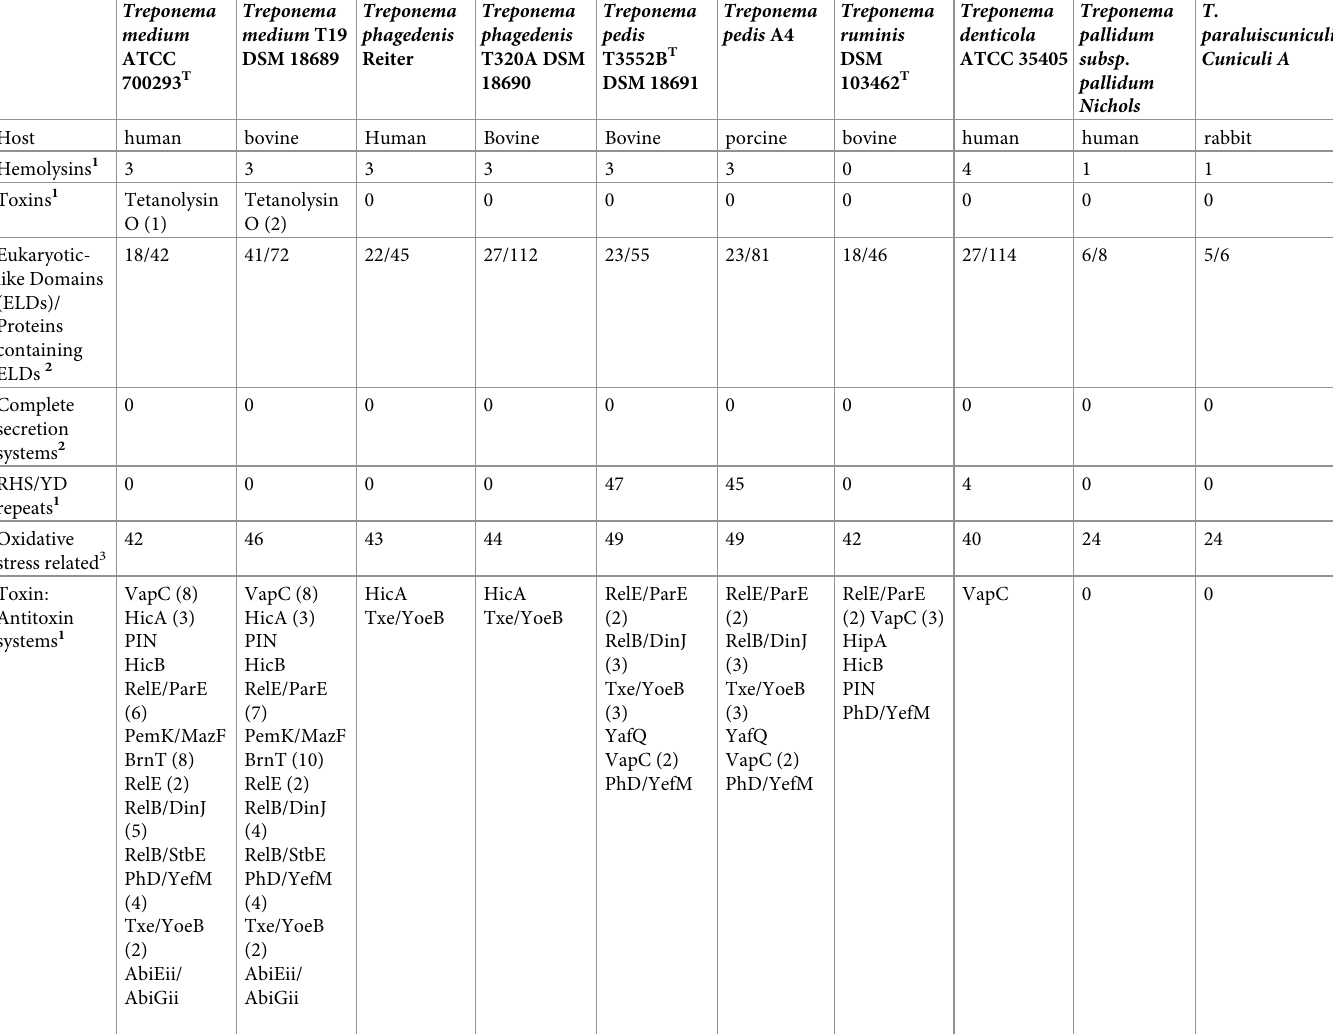
Table 2. Distribution of unique and shared Gram-negative bacterial survival and virulence associated genes across bovine and human